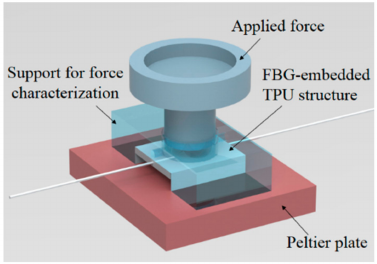
Figure 3. Experimental setup for the FBG sensors (embedded in the TPU structure)